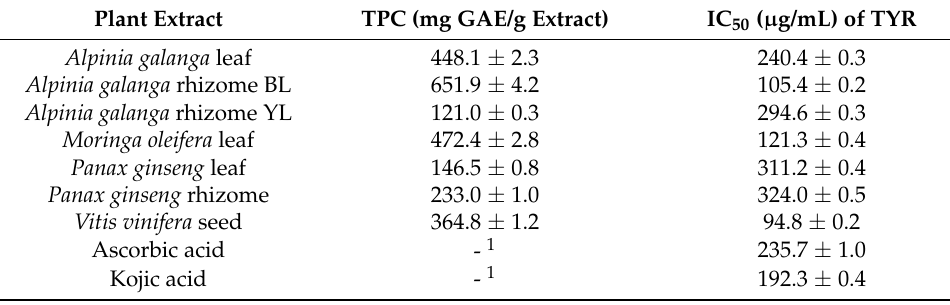
Table 1. Total phenolic content (TPC) and IC 50 values for TYR. Plant Extract TPC (mg GAE/g Extract) IC 50 ( µ g/mL) of TYR Alpinia galanga leaf 448.1 ±